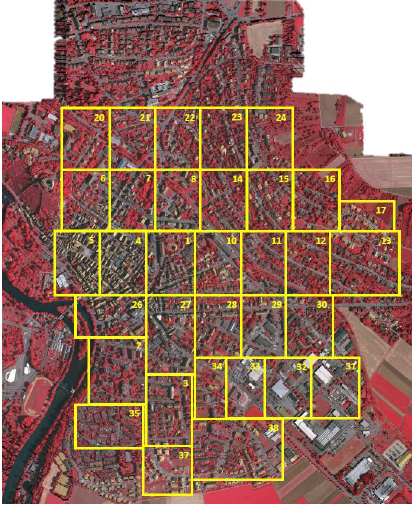
Figure 9. Outlines of all patches overlaid with TOP mosaic of Vaihingen dataset. RGB visual channels correspond to near-infrared, red and green bands delivered by camera. Table 1. Partitions of datasets.